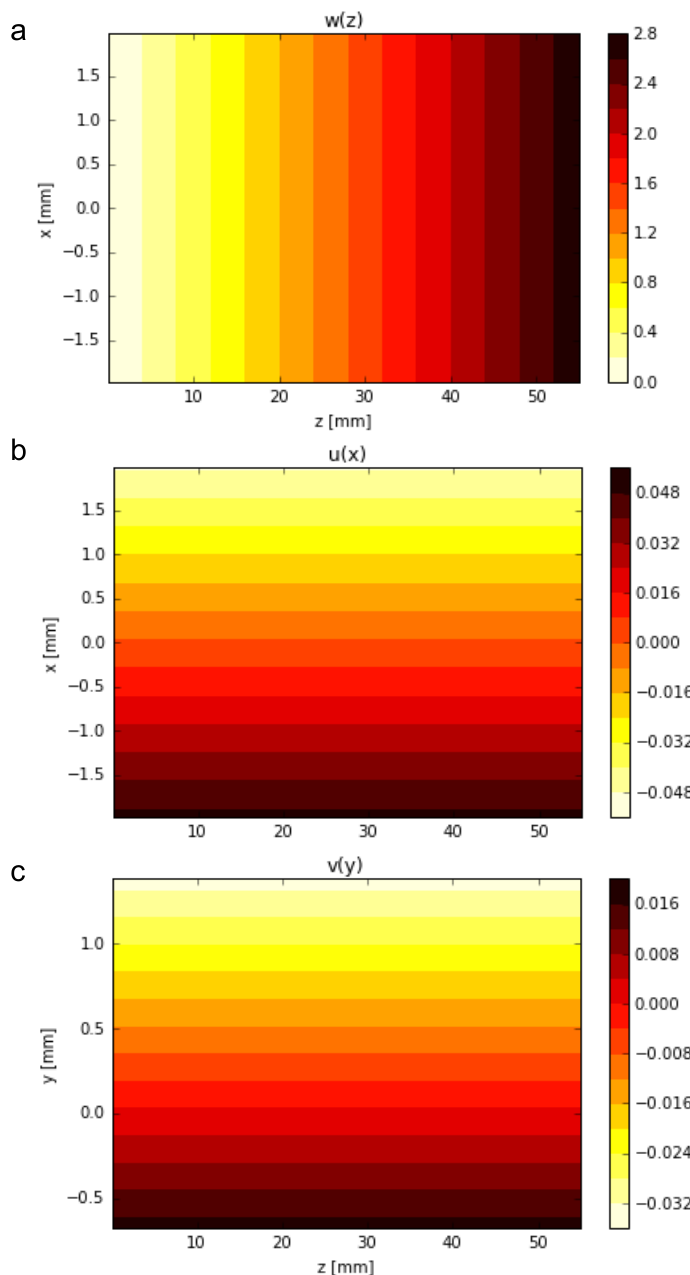
Figure 2. ( a ) The theoretical evolution of the axial displacement for a fully incompressible nervous specimen with a length of 55 mm and a section of 1.398 mm × 4.000 mm; the axial field of displacements was linearly increasing with the z coordinate. ( b ) Lateral contraction; the displacement field was expressed as a function of x . ( c ) Lateral contraction: the displacement field was expressed as a function of y . In both cases, the field of displacements was symmetric with respect to the central axis as well as invariant with respect to the z